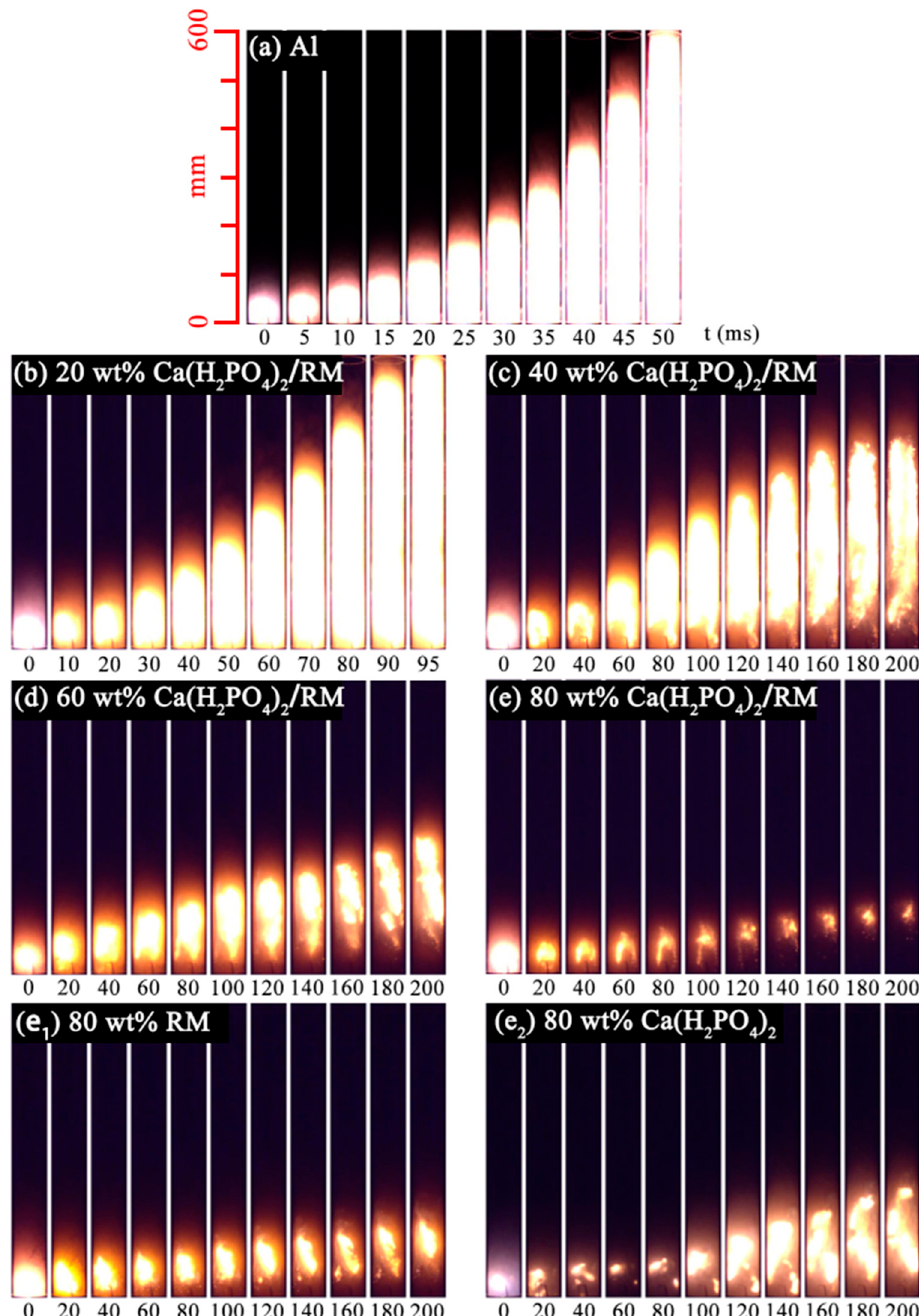
Figure8. Figure 8. Suppression effect for aluminum dust explosion flame propagation among different suppressants.